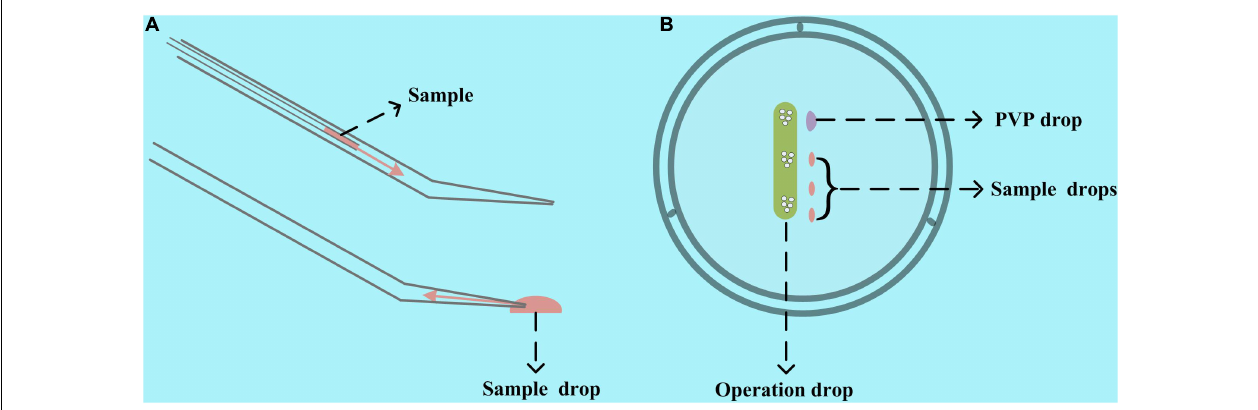
FIGURE 2 | Schematic diagram of preparing the operation dish. (A) Two ways to add samples to the microinjection pipette. One is from the tail with another pipette injecting the sample, and the other is to use the microinjection pipette itself to aspirate the sample from its injection tip. The second one was used in our study. (B) An operation and PVP drop and one or several sample drops are included in the operation dish. A lid rather than a 35- or 60-mm Petri dish itself would be a better container for making the operation